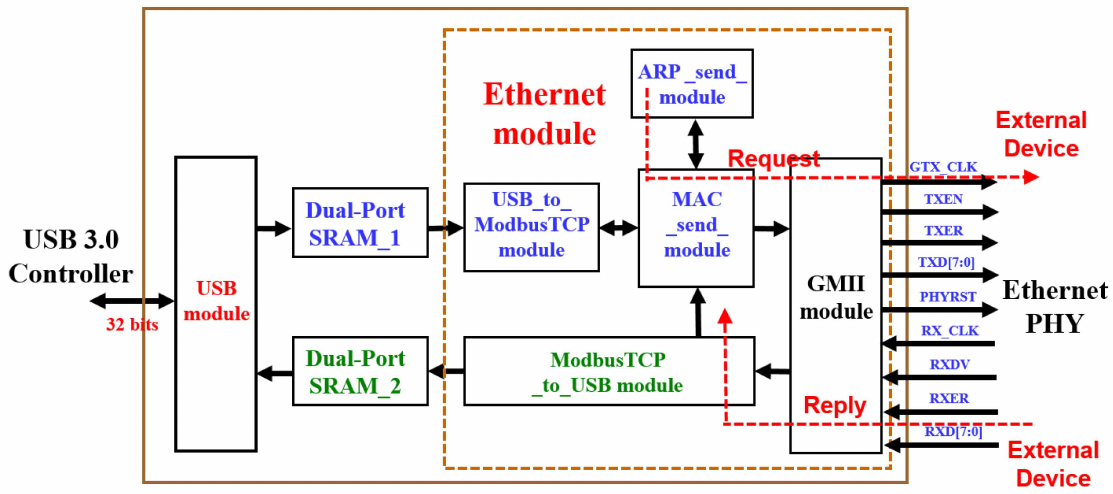
Figure 2. Architecture diagram of the proposed transformation and transmission interface between Modbus TCP and